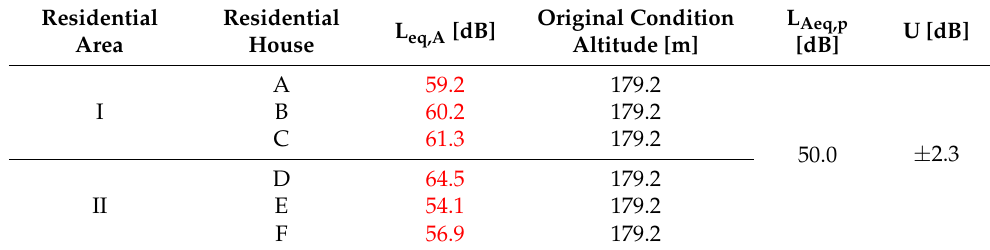
Table 3. Measured noise values in residential